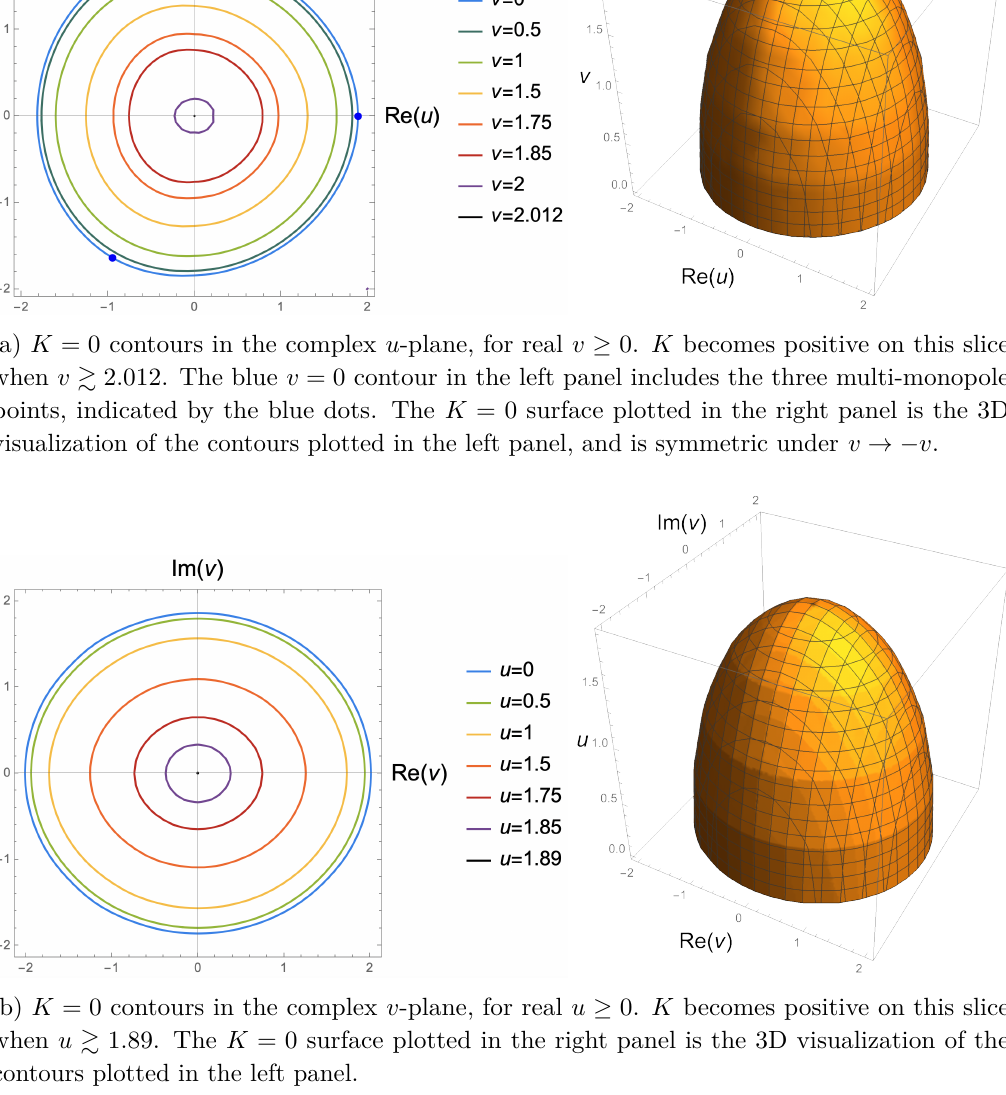
0 . K becomes positive on this slice ≥